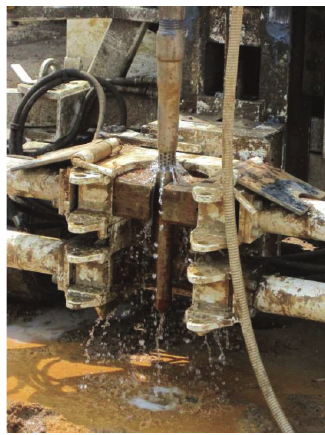
Figure 8: Photo of the Perm´eafor on the